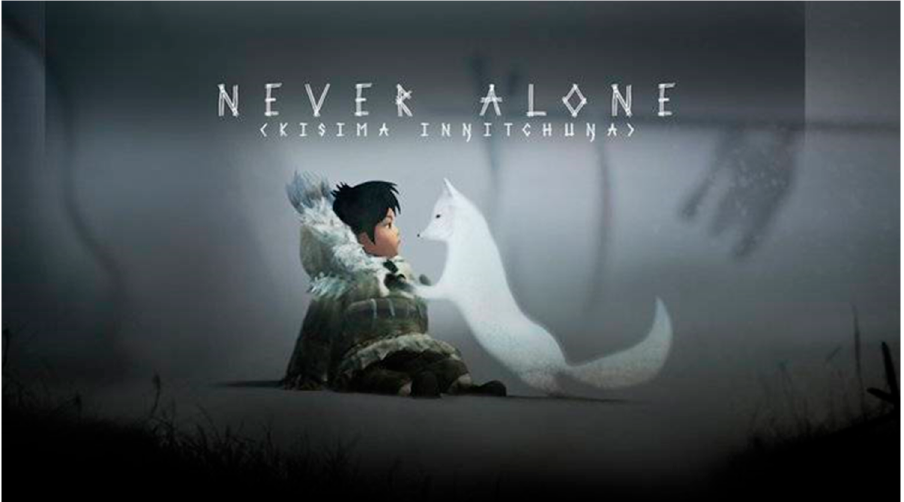
Figure 2. Video game “Never Alone” (2016) by Upper One Games and E-Line Media, based on a traditional Iñupiaq tale. Used by permission of Amy Fredeen and E-Line Media.